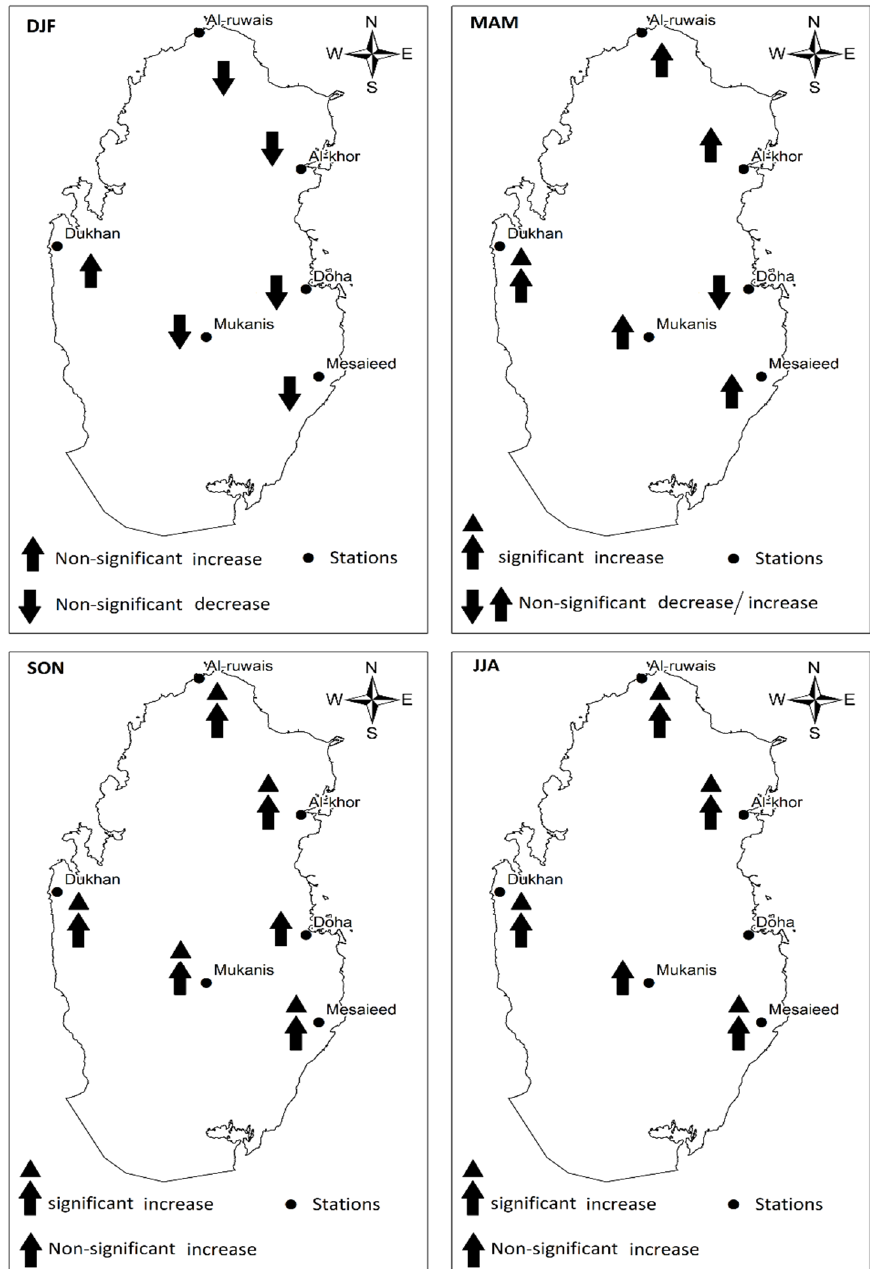
Figure 8. Station wise seasonal monthly average rainfall trends. DJF = December, January February; MAM = March, April, May; JJA = June July August; SON = September, October, November). Data source QMD.